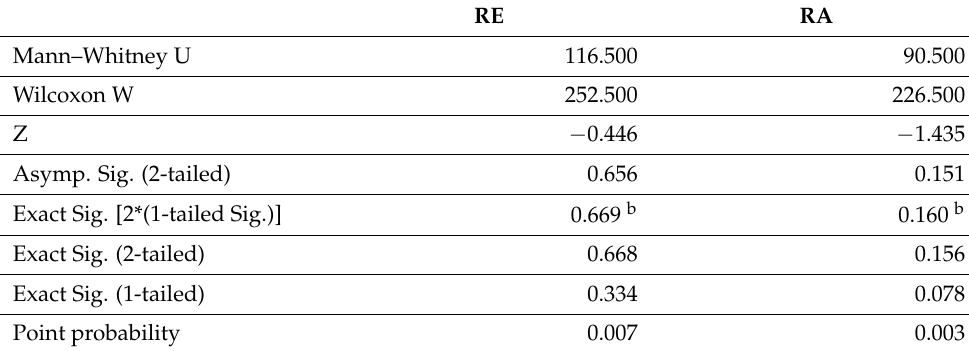
Table 2. Test Statistics a